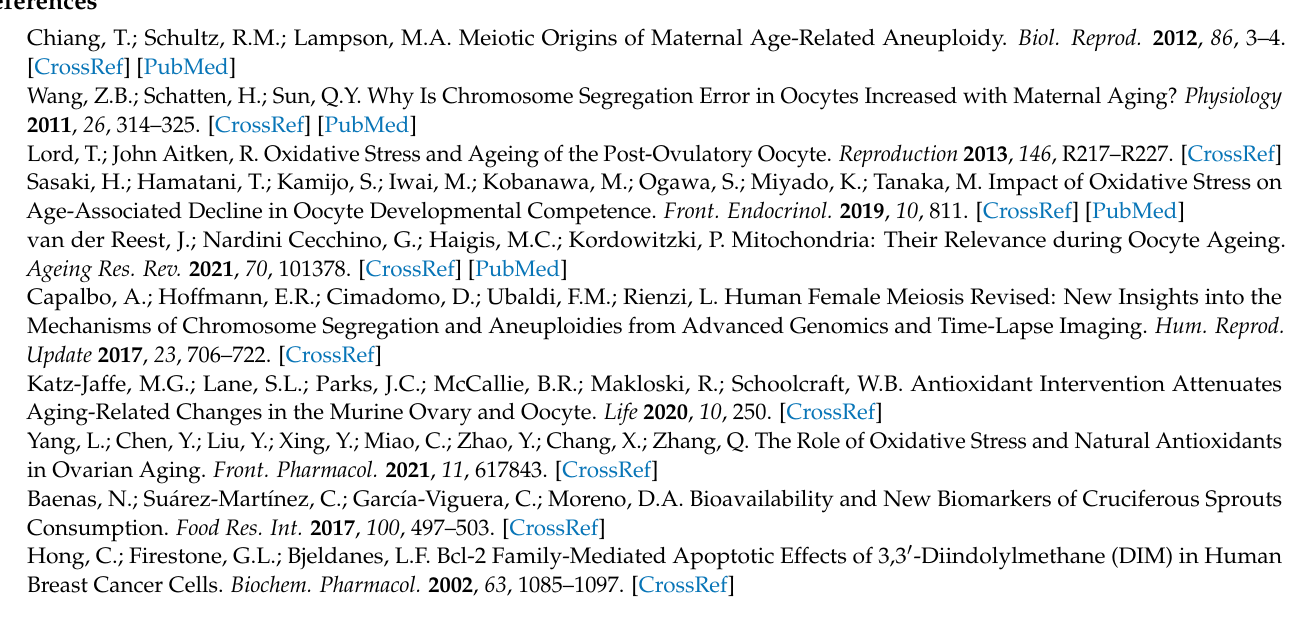
Figure S2: DIM supplementation suppresses the level of ROS in aged prdx-2 mutants; Figure S3: The effect of DIM supplementation on reproductive capacity from the day 1 to day 6 post L4 stage; Figure S4: The mRNA levels of egl-1 and ced-13 in day 1 and day 4 adult worms with DIM supplementation; Figure S5: Three sets of western blot images; Figure S6: DIM supplementation did not induce the expression of